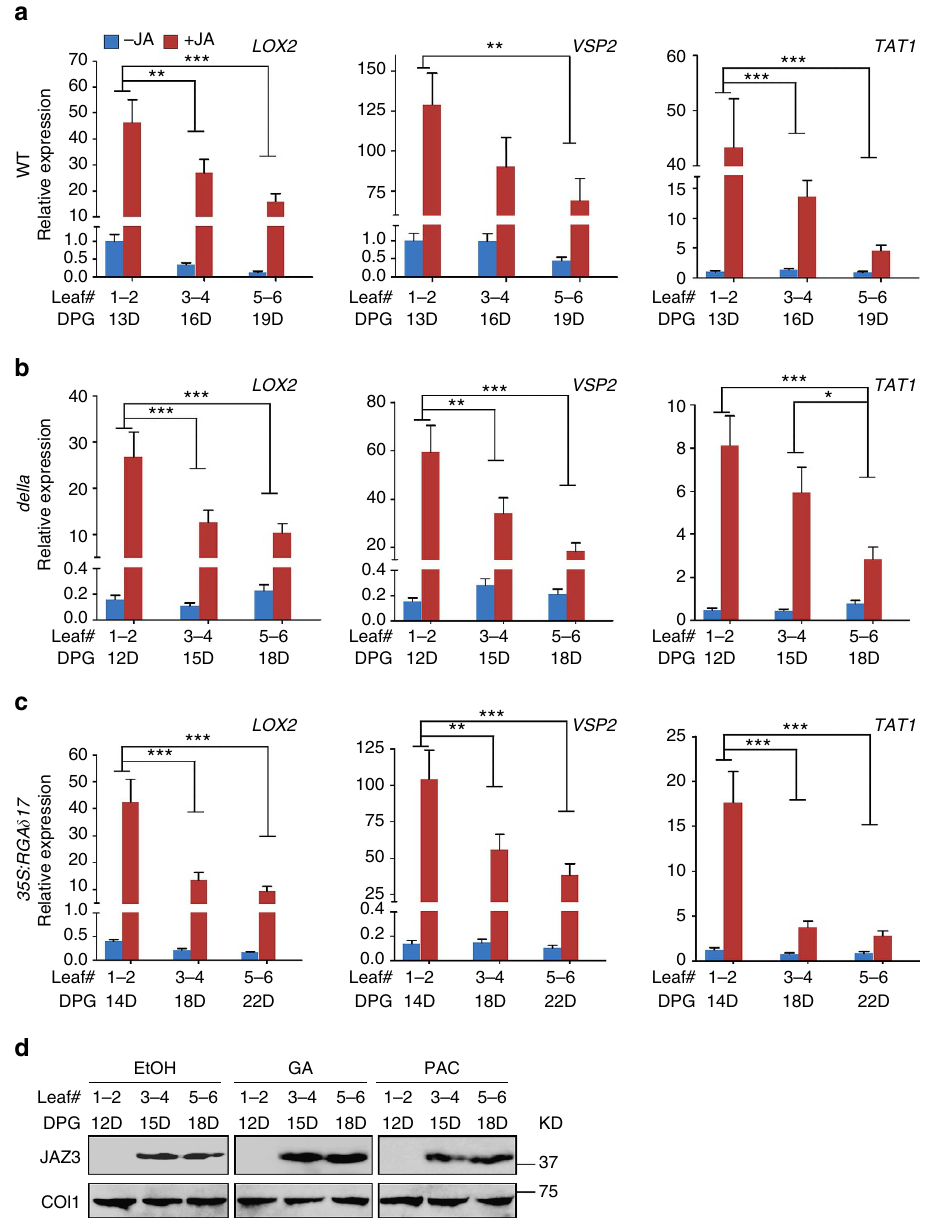
Figure 6 | The age-dependent JA response attenuation is not altered by GA. qPCR analyses of the transcript levels of LOX2 , VSP2 and TAT1 in leaves of the wild-type (WT) ( a ), the penta della -deficient mutant ( della ) ( b ) and the DELLA over-expressor ( 35S:RGA d 17 ) ( c ) plants. All plants are in Ler-0 background. Plants in LD condition were treated with 50 m M MeJA ( þ JA) or ethanol ( (cid:2) JA) as control, new leaves (leaf #1–2, 3–4 and 5–6) were harvested at the indicated DPG and analysed. The expression in the first pair of leaves (leaf #1–2) of the wild-type control ( (cid:2) JA) plants was set to 1. Data were analysed by multiple comparisons (Tukey test) followed by two-way ANOVA (* P o 0.05, ** P r 0.01, *** P r 0.001). Error bars represent ± s.d. ( n ¼ 3). ( d ) JAZ3 protein accumulation in GA and PAC treated plants. Ten days after germination, the LD grown 35S:JAZ3-HA plants were sprayed with 50 m M GA or PAC one time per day, and the new leaves were harvested 2h after the treatment at indicated days (D) post germination. JAZ3-HA was detected using anti-HA antibody. COI1 in each sample was detected using anti-COI1 antibody. ANOVA, analysis of variance; KD, kilodalton.